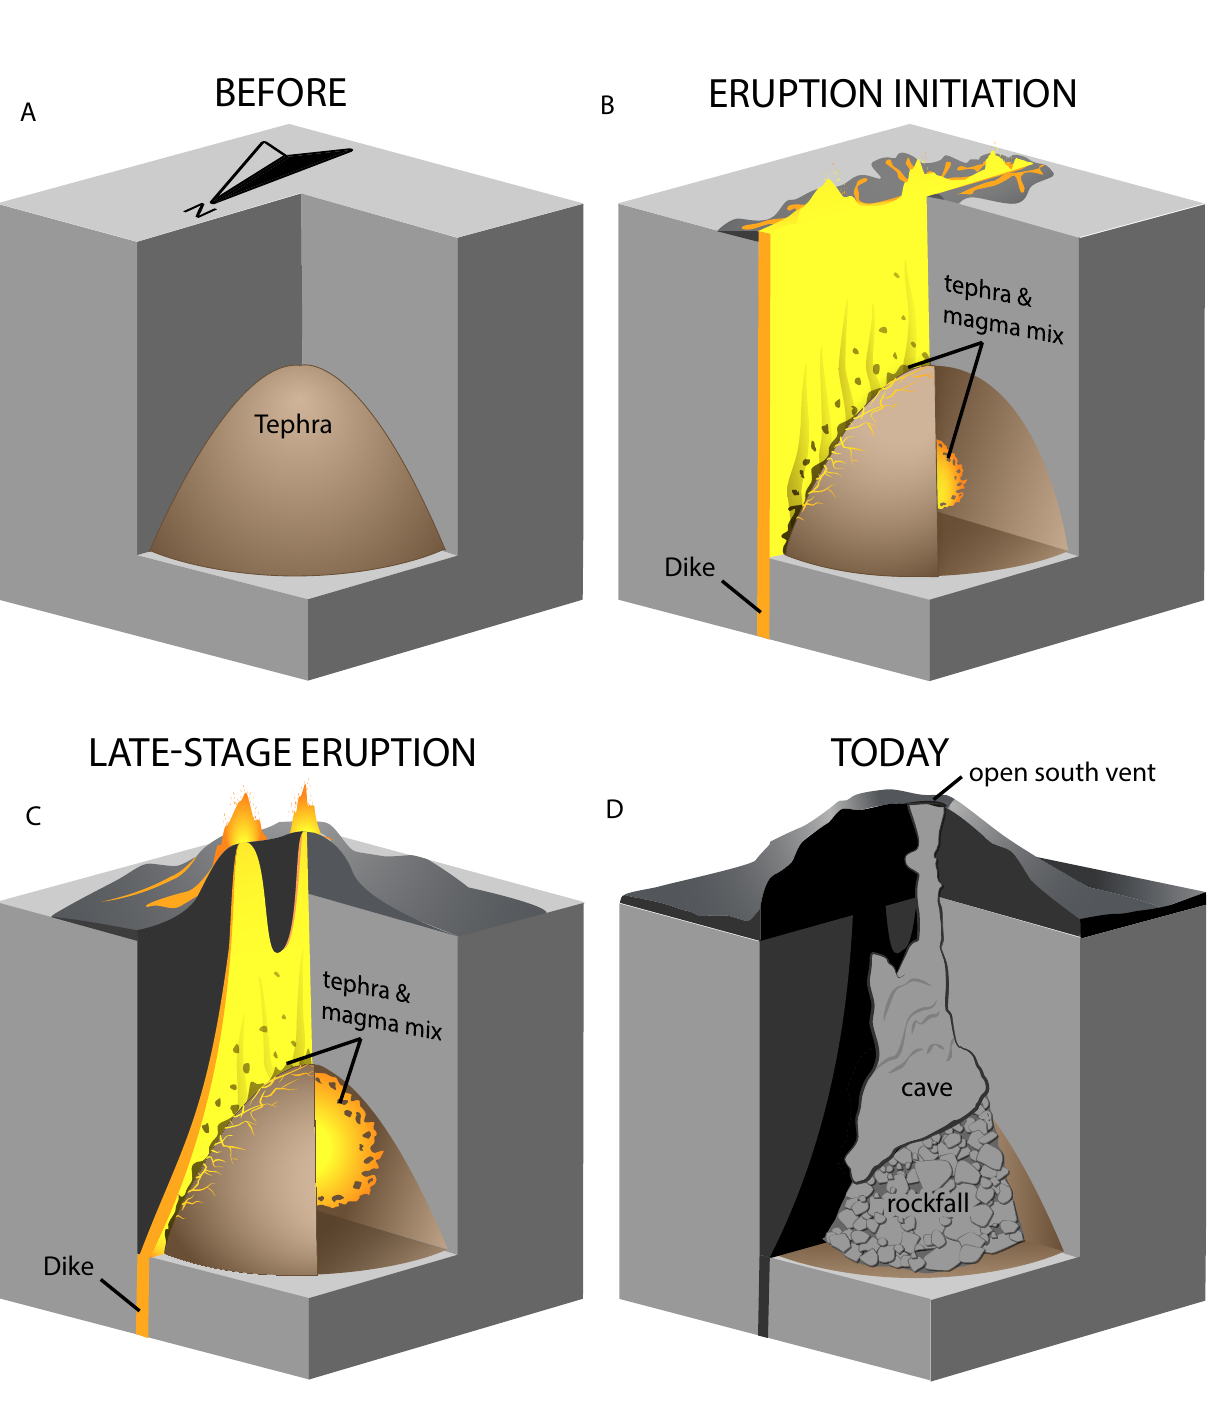
Figure 13: Block diagram of cave formation during the eruption of Thríhnúkagígur. Prior to eruption [A] a tephra cone is buried under lava flows. At the onset of eruption [B], a dike crosscut the tephra and overlying lavas, commencing a fissure eruption with multiple events and limited interaction with the intersected tephra body. As the eruption progressed [C], unconsolidated tephra was entrained by the dike and flow became focused at two vents. Tephra incorporation created vacancy beneath the vent, within the conduit. As the eruption ended, lava drainback left the south vent evacuated and open to the surface. Rockfall from the cave ceiling has filled much of the region where tephra had been incorporated and moved the cave upward from its original location in the conduit into overlying country rock [D]. Illustration by Natalie Renier, WHOI Creative Studio © Woods Hole Oceanographic